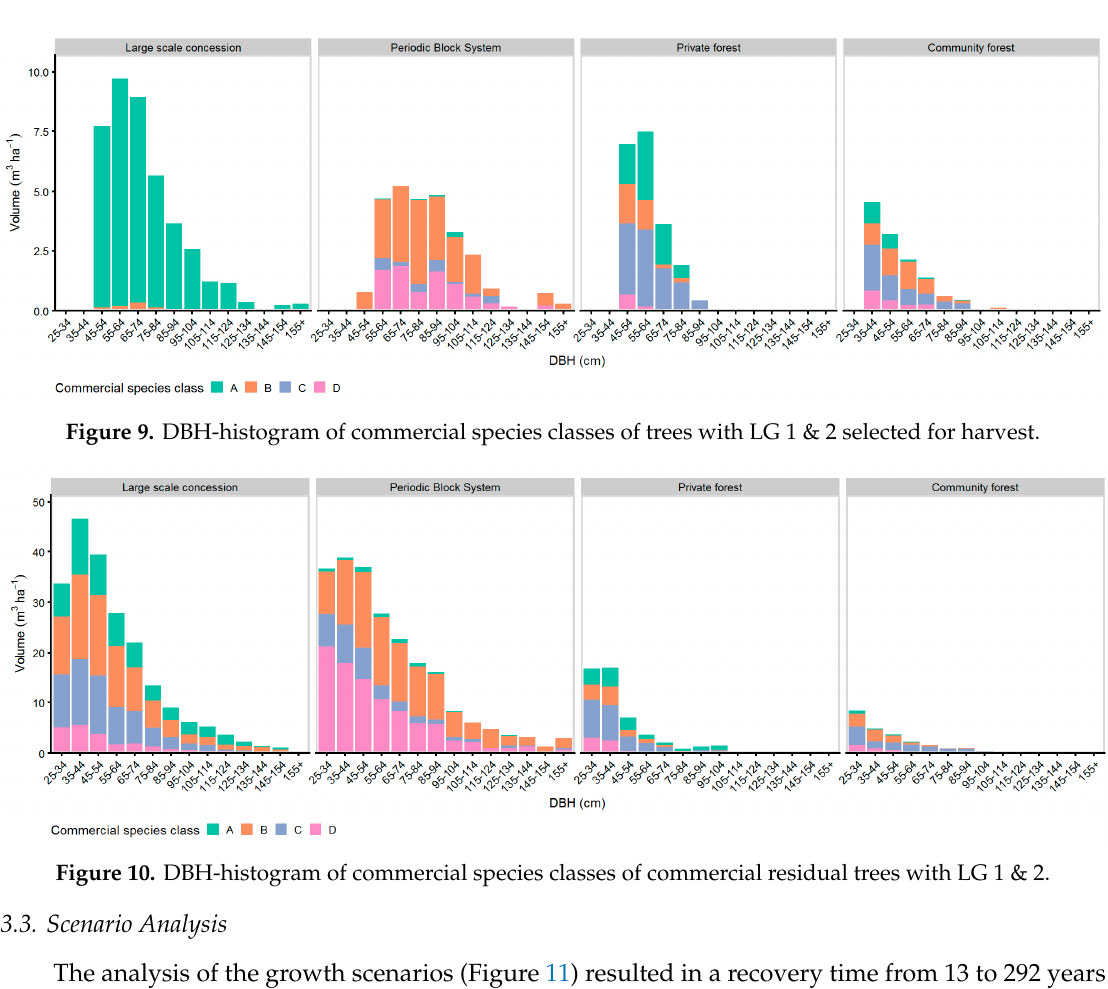
Figure 10. DBH-histogram of commercial species classes of commercial residual trees with LG 1 & 2.